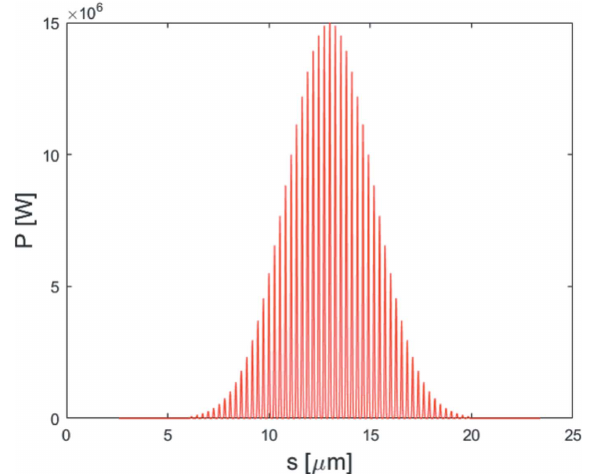
Figure 2 Longitudinal profile distribution of the HHG seed